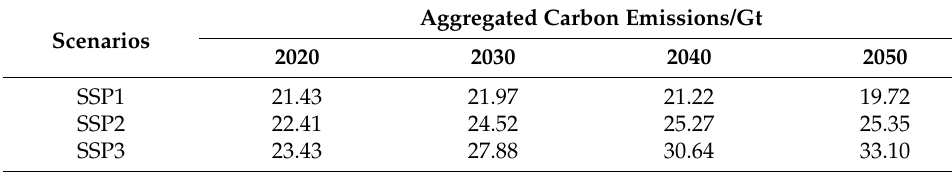
Figure 5. The elasticity coefficients of energy consumption and its changes in different income groups: ( a ) The elasticity coefficiences of energy consumption structure in B&R countries; ( b ) The changes in the energy consumption structure of three income groups from 1990–2014. Table 4. Carbon emissions of B&R countries in different